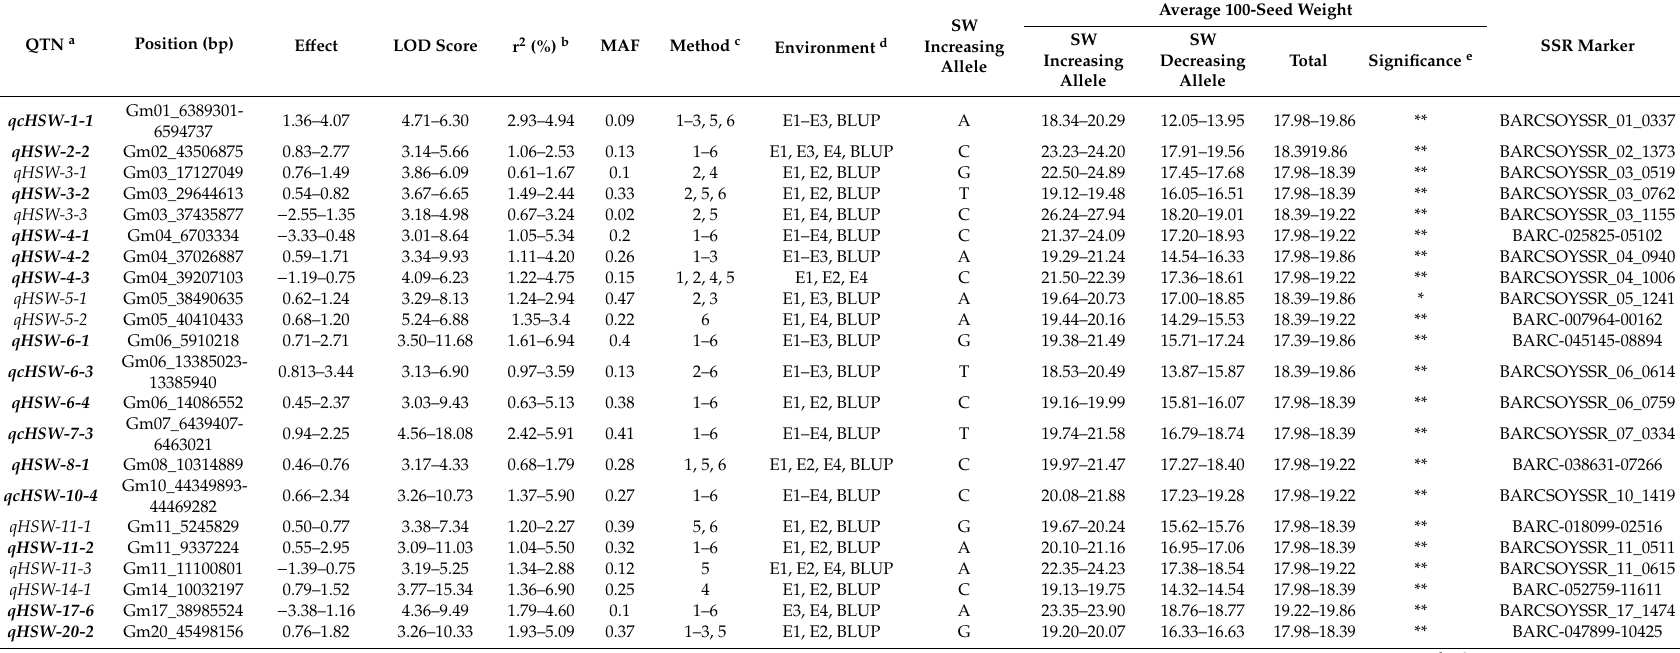
Table 3. Stable QTNs for soybean 100-seed weight identified in multiple environments and the BLUP